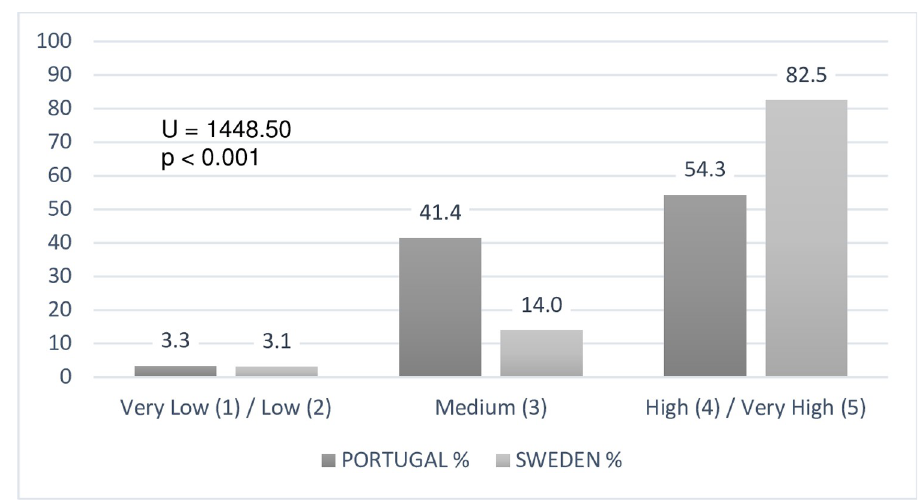
Fig 7. Teachers’ confidence degrees about their pedagogical choices (N =